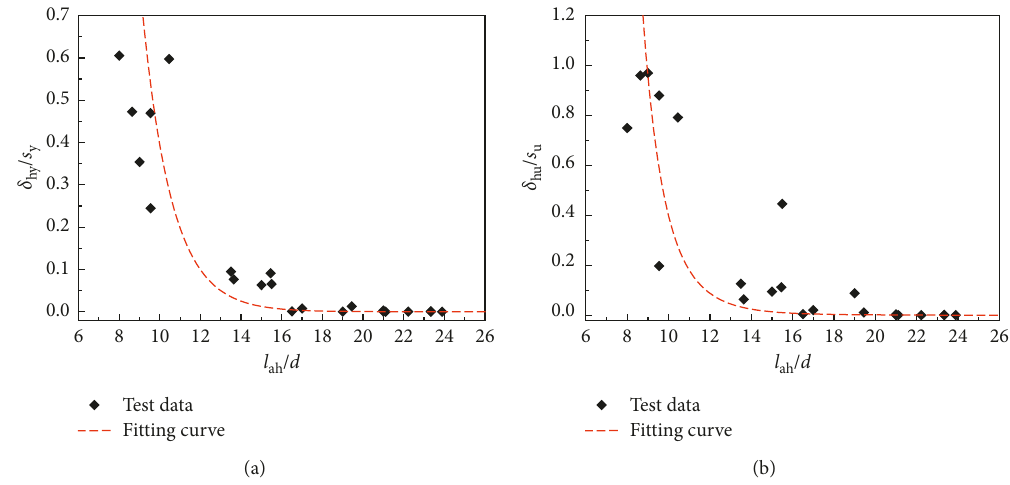
Figure 12: Relationship between l